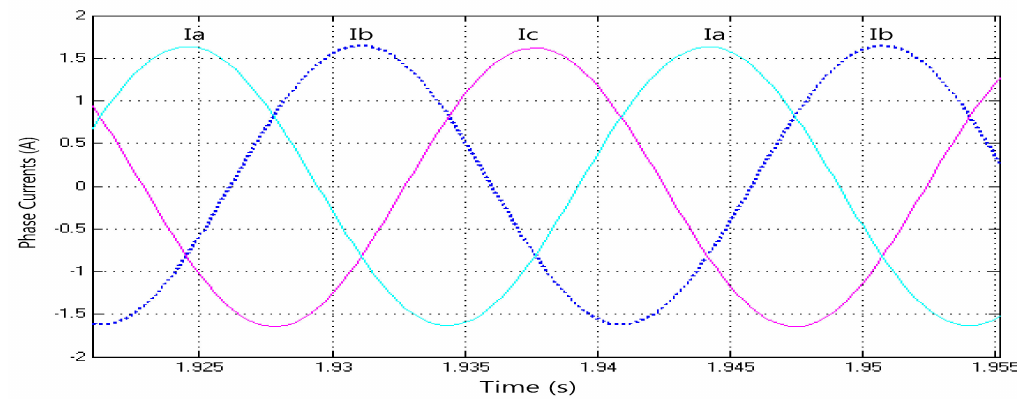
Figure 10. Load phase current of MATLAB / Simulink